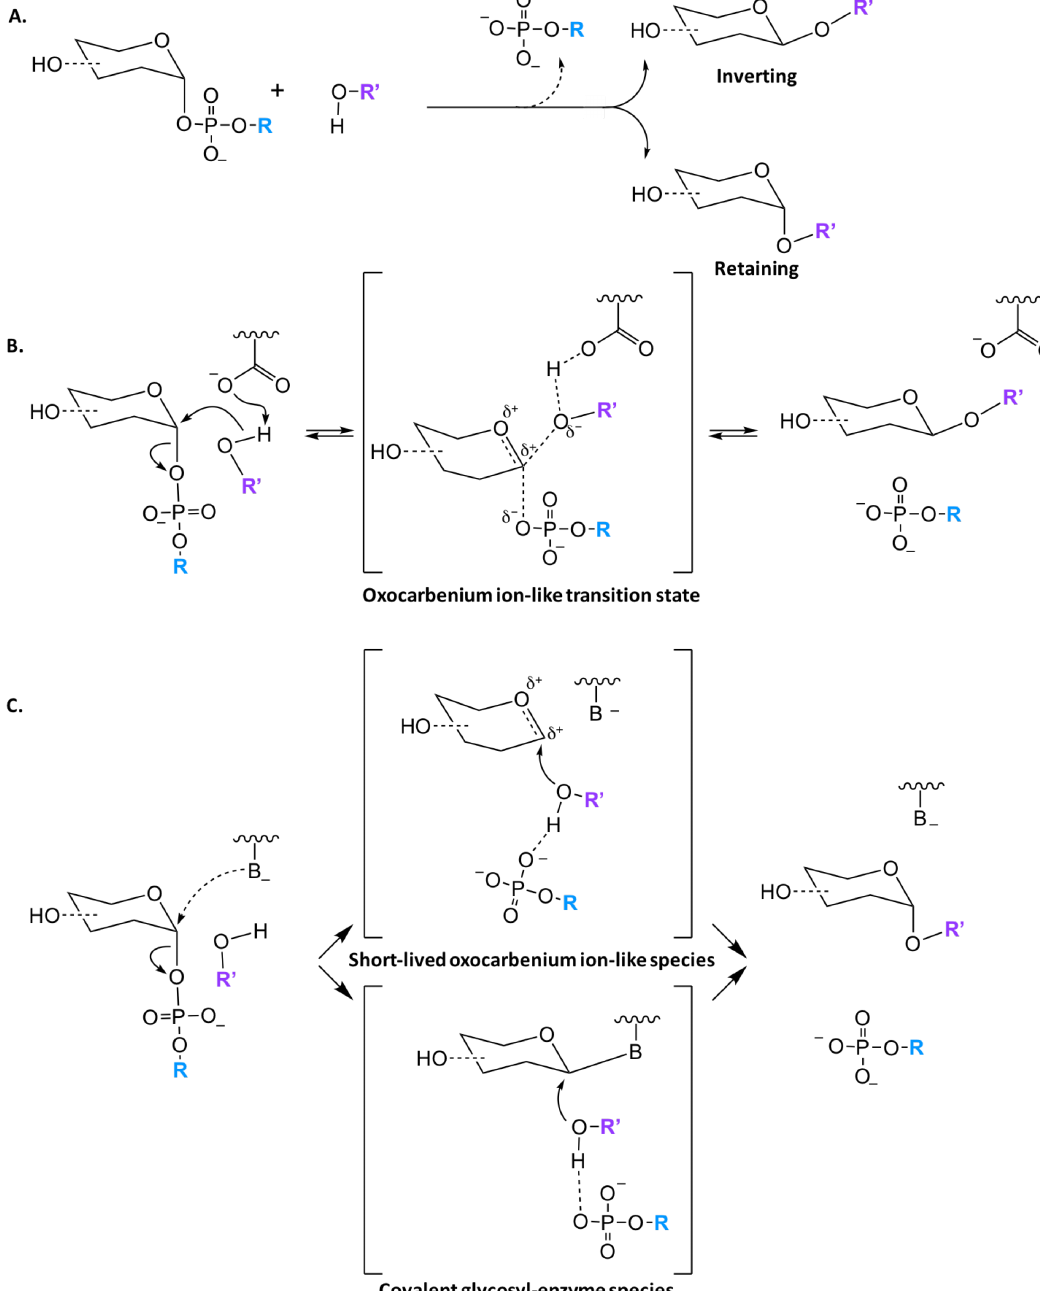
Figure 3. Proposed catalytic mechanism of GT enzymes. ( A ) The transfer of a sugar moiety is performed with either inversion or retention of the anomeric carbon in respect to the sugar donor substrate; ( B ) Schematic of S N 1-like mechanism for inverting GTs, where a single oxocarbenium ion-like transition state is formed; ( C ) There are currently two mechanisms for retaining GTs enzymes either through the formation of a short-lived oxocarbenium ion-like species or a covalent glycosyl-enzyme